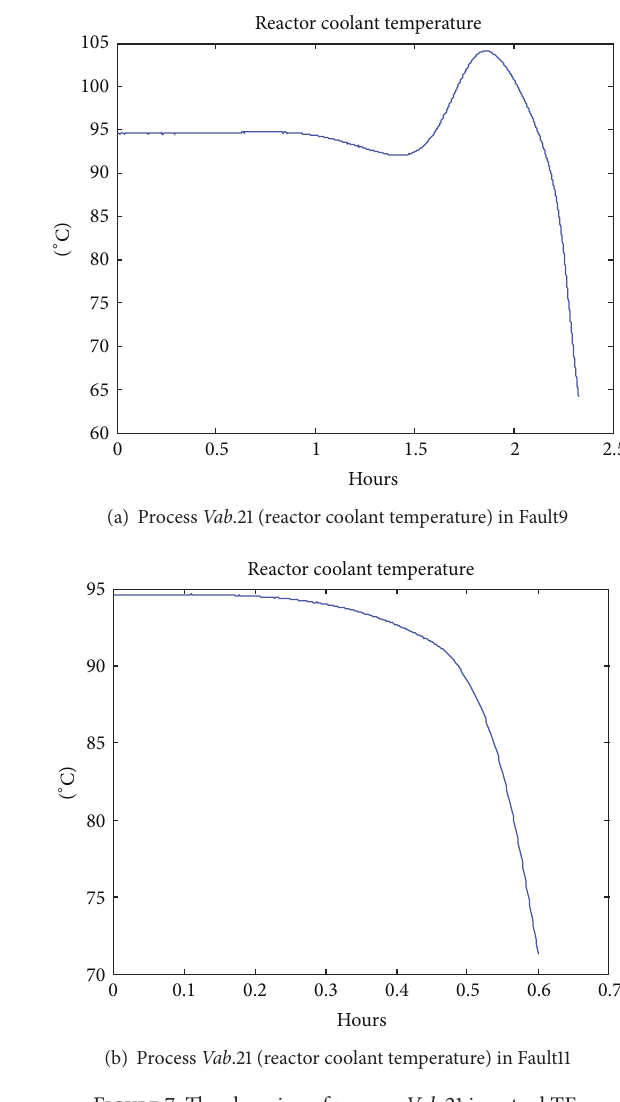
Figure 7: The changing of process Vab .21 in actual